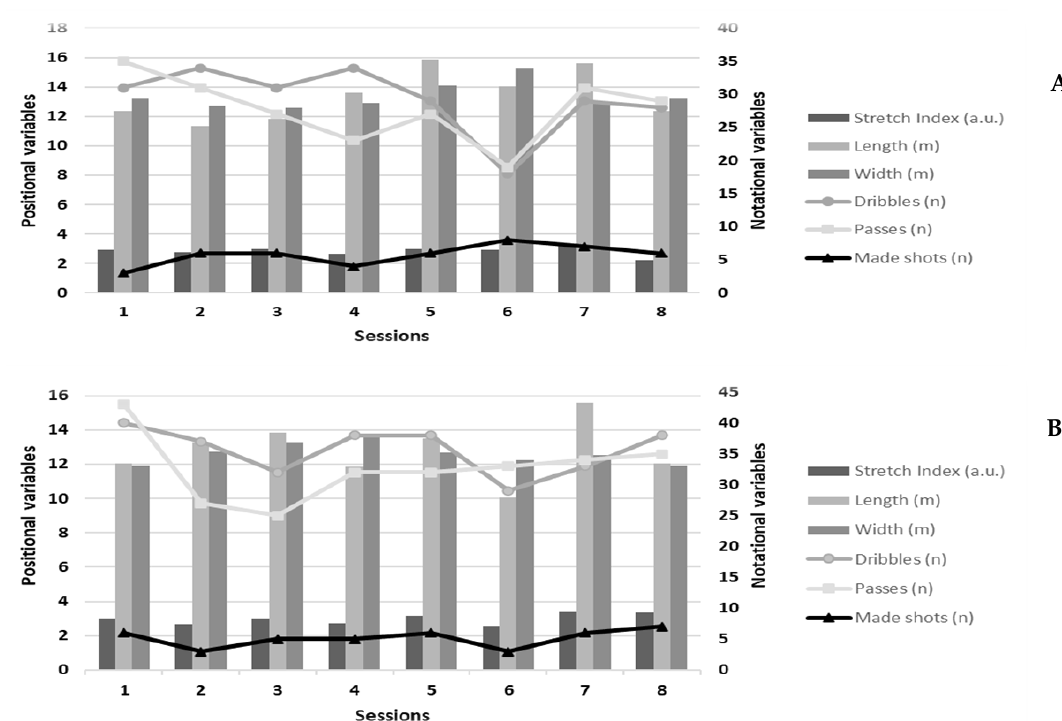
Figure 2. Representation of the absolute values for the positional and notational variables for each session: ( A ) = pre-test; ( B ) = post-test.